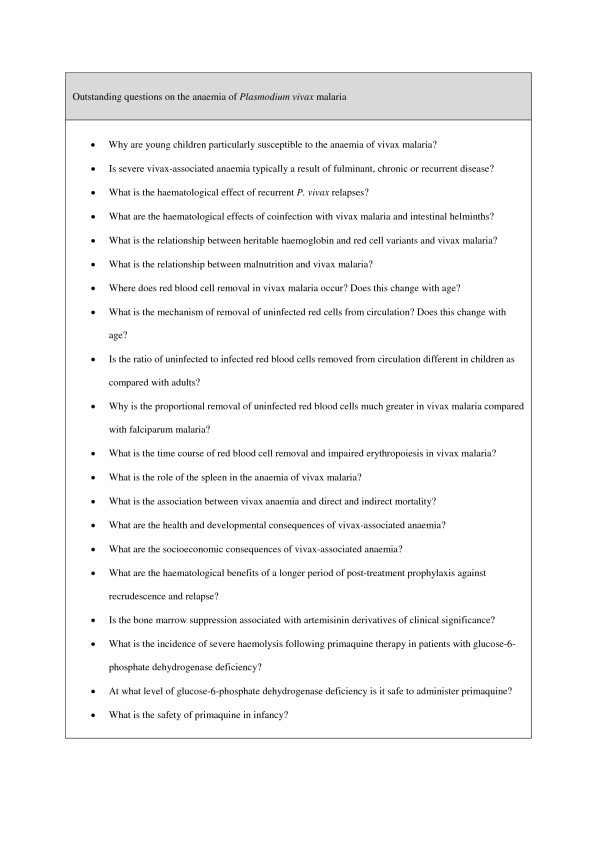
Outstanding questions on the anaemia ofPlasmodium vivaxmalaria.